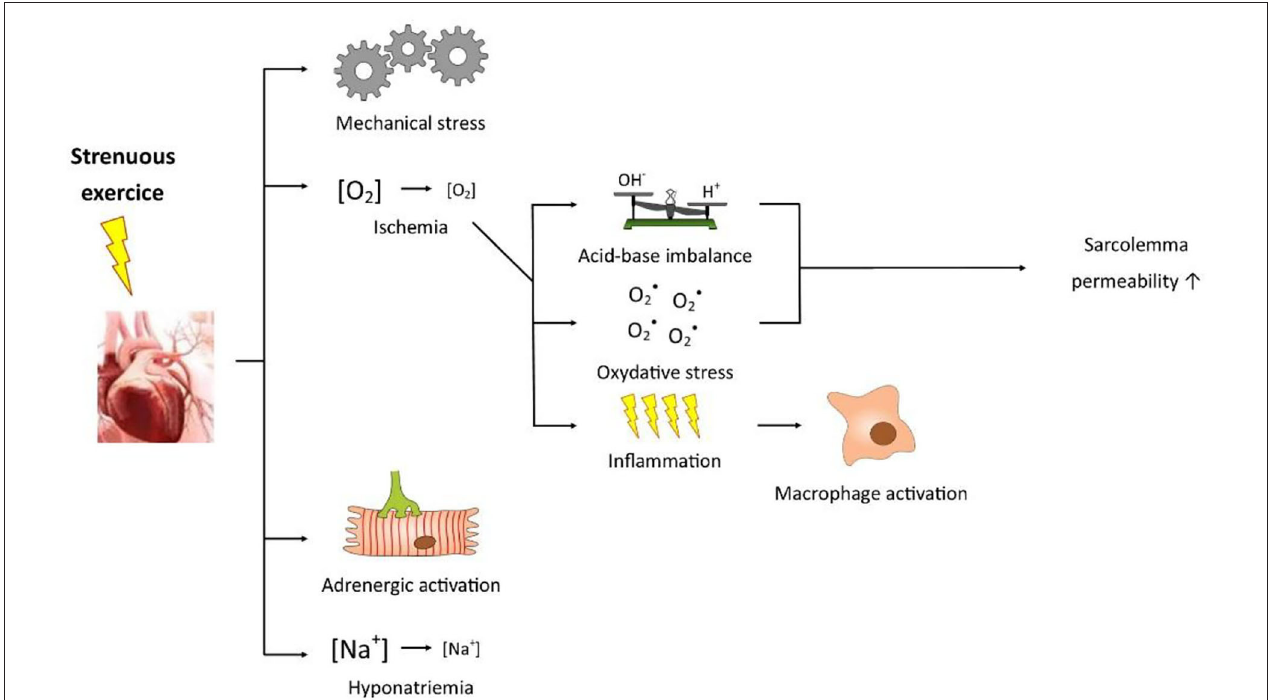
FIGURE 1 | Figure showing how a prolonged strenuous exercise may impact normal cardiovascular physiological processes.